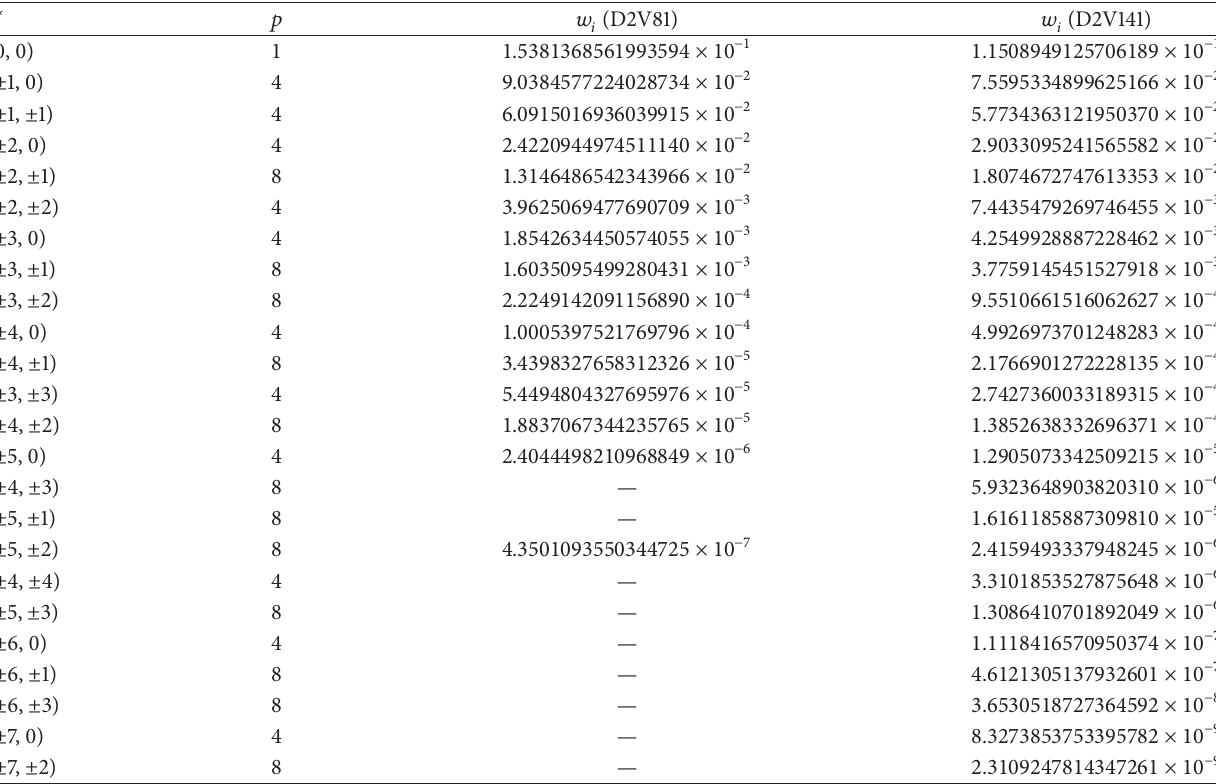
Table 2: Specification of a sixth-order (D2V81) and eighth-order (D2V141) lattice-Boltzmann stencil: 𝑎 𝑠 = 0.970008498739395 and = 0.8369204054303525 , respectively. The second column indicates the number of velocity vectors, obtained by permutating the vector 𝑎 𝑠 components, sharing the given